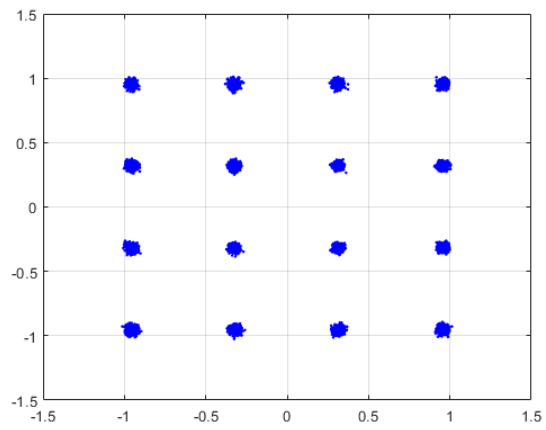
Figure 3. Measured constellations of the base-band platform.